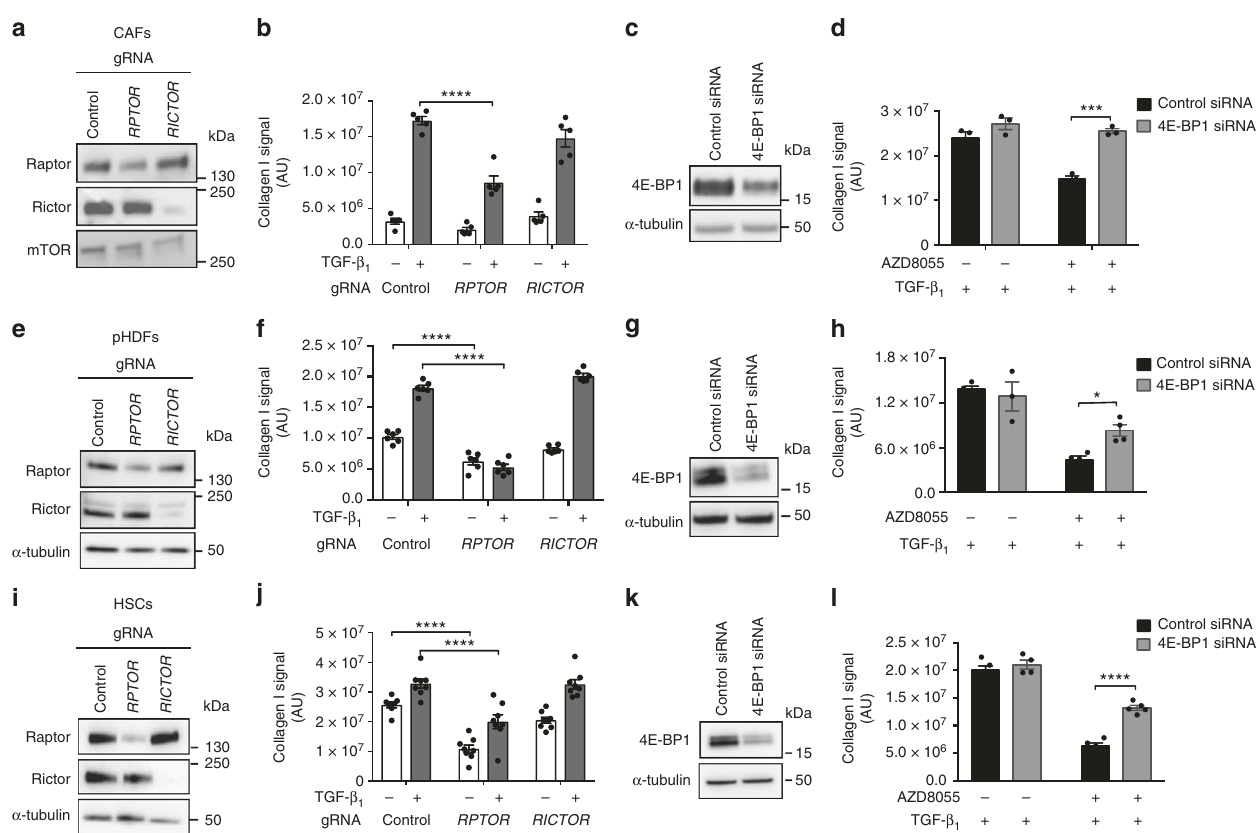
Fig. 9 mTORC1/4E-BP1 axis mediates collagen I deposition in other mesenchymal cells. Lung adenocarcinoma-associated fi broblasts (CAFs), primary human dermal fi broblasts (pHDFs), and primary hepatic stellate cells (HSCs) were modi fi ed by CRISPR-Cas9 gene editing using gRNAs targeting exon 26 of RPTOR or exon 29 of RICTOR . Analysis of the resultant levels of Raptor and Rictor protein are shown ( a , e , i ). CRISPR-Cas9-edited CAFs, pHDFs, and HSCs were stimulated with TGF- β 1 (1 ng/ml) for 72 h, with collagen I deposition assessed by macromolecular crowding assay ( b , f , j ). Data are expressed as collagen intensity ( n = 4 fi elds of view imaged per well) normalized to cell count. Data are presented as mean ± SEM (CAFs n = 5, pHDFs n = 6, HSCs n = 8). CAFs, pHDFs, and HSCs were transfected with control siRNA or siRNA targeting 4E-BP and 4E-BP1 protein expression was measured ( c , g , k ). Following transfection, cells were preincubated with 1 μ M (CAFs) or 300 nM (pHDFs, HSCs) AZD8055 or vehicle prior to stimulation with TGF- β 1 for 72 h. Collagen I deposition was analyzed by macromolecular crowding assay ( d , h , l ). Data are expressed as collagen intensity ( n = 4 fi elds of view imaged per well) normalized to cell count. Data are presented as mean ± SEM (CAFs n = 3, pHDFs n = 4, HSCs n = 5). Differences between groups were evaluated with two-way ANOVA with Tukey multiple comparison testing, * p < 0.05, *** p < 0.001, **** p <